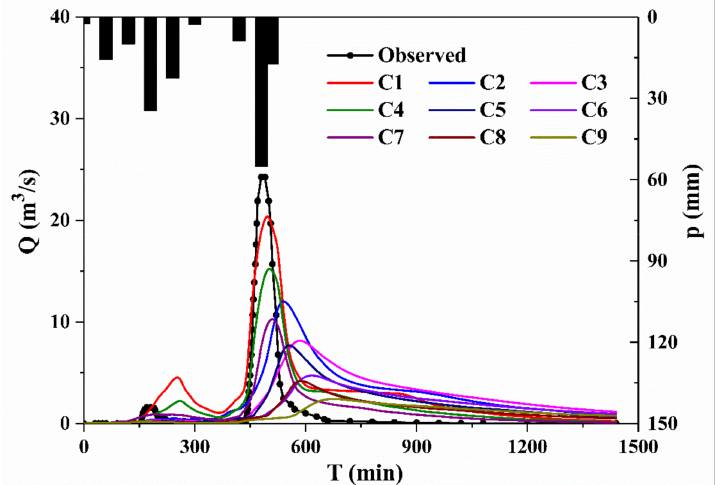
Figure 9. Comparison of the simulated and observed flood hydrographs over the calibration